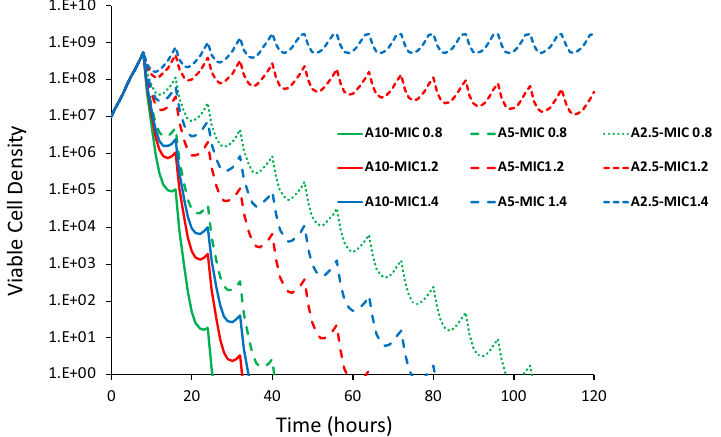
Figure 5. Simulation results of the relationship between the dose of the antibiotic and MIC. Simulations were made of treatment every 8 h with a drug (10, 5 and 2.5 µg/ml) of cells with the MIC of 0.8, 1.2 and 1.5 µg/ml of the drug and the changes in the viable cell density observed. Hill function parameters V MAX = 1.0, V MIN = − 3.0, κ = 1.0, continuous culture parameters, k = 1, e = 5 × 10 –7 , w = 0.5 and C = 1,000 (see the equations in the “Materials and methods” section. See supplemental Figure S2 for the pharmacodynamic Hill functions and the rates of kill bacteria exposed to antibiotics with these Hill function parameters.